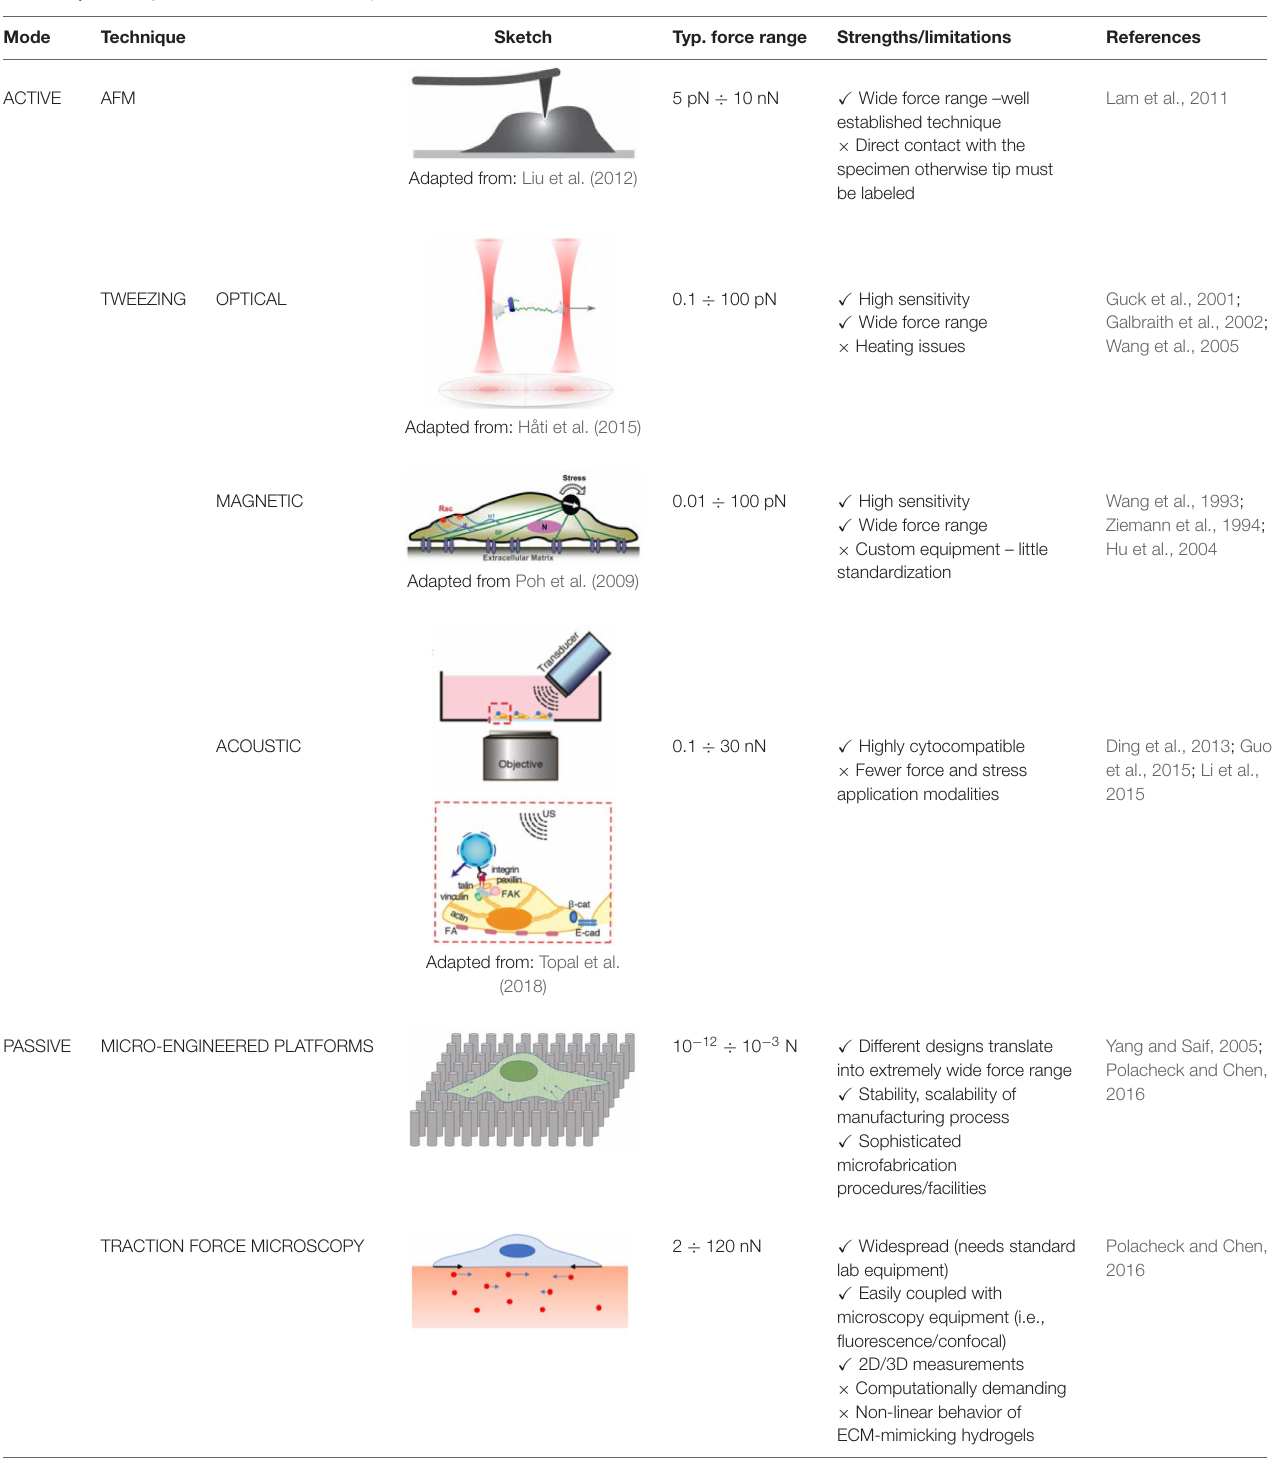
TABLE 1 | Summary of the most relevant techniques for cell mechanical